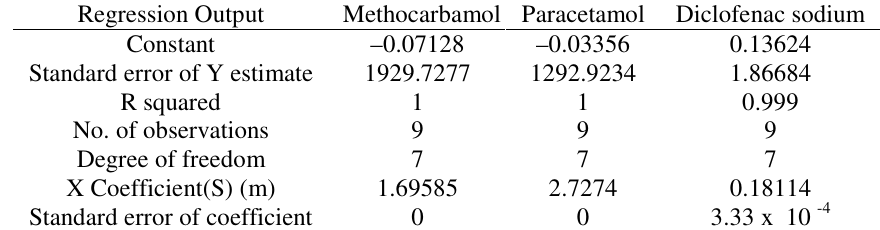
Table 1. Linear regression data